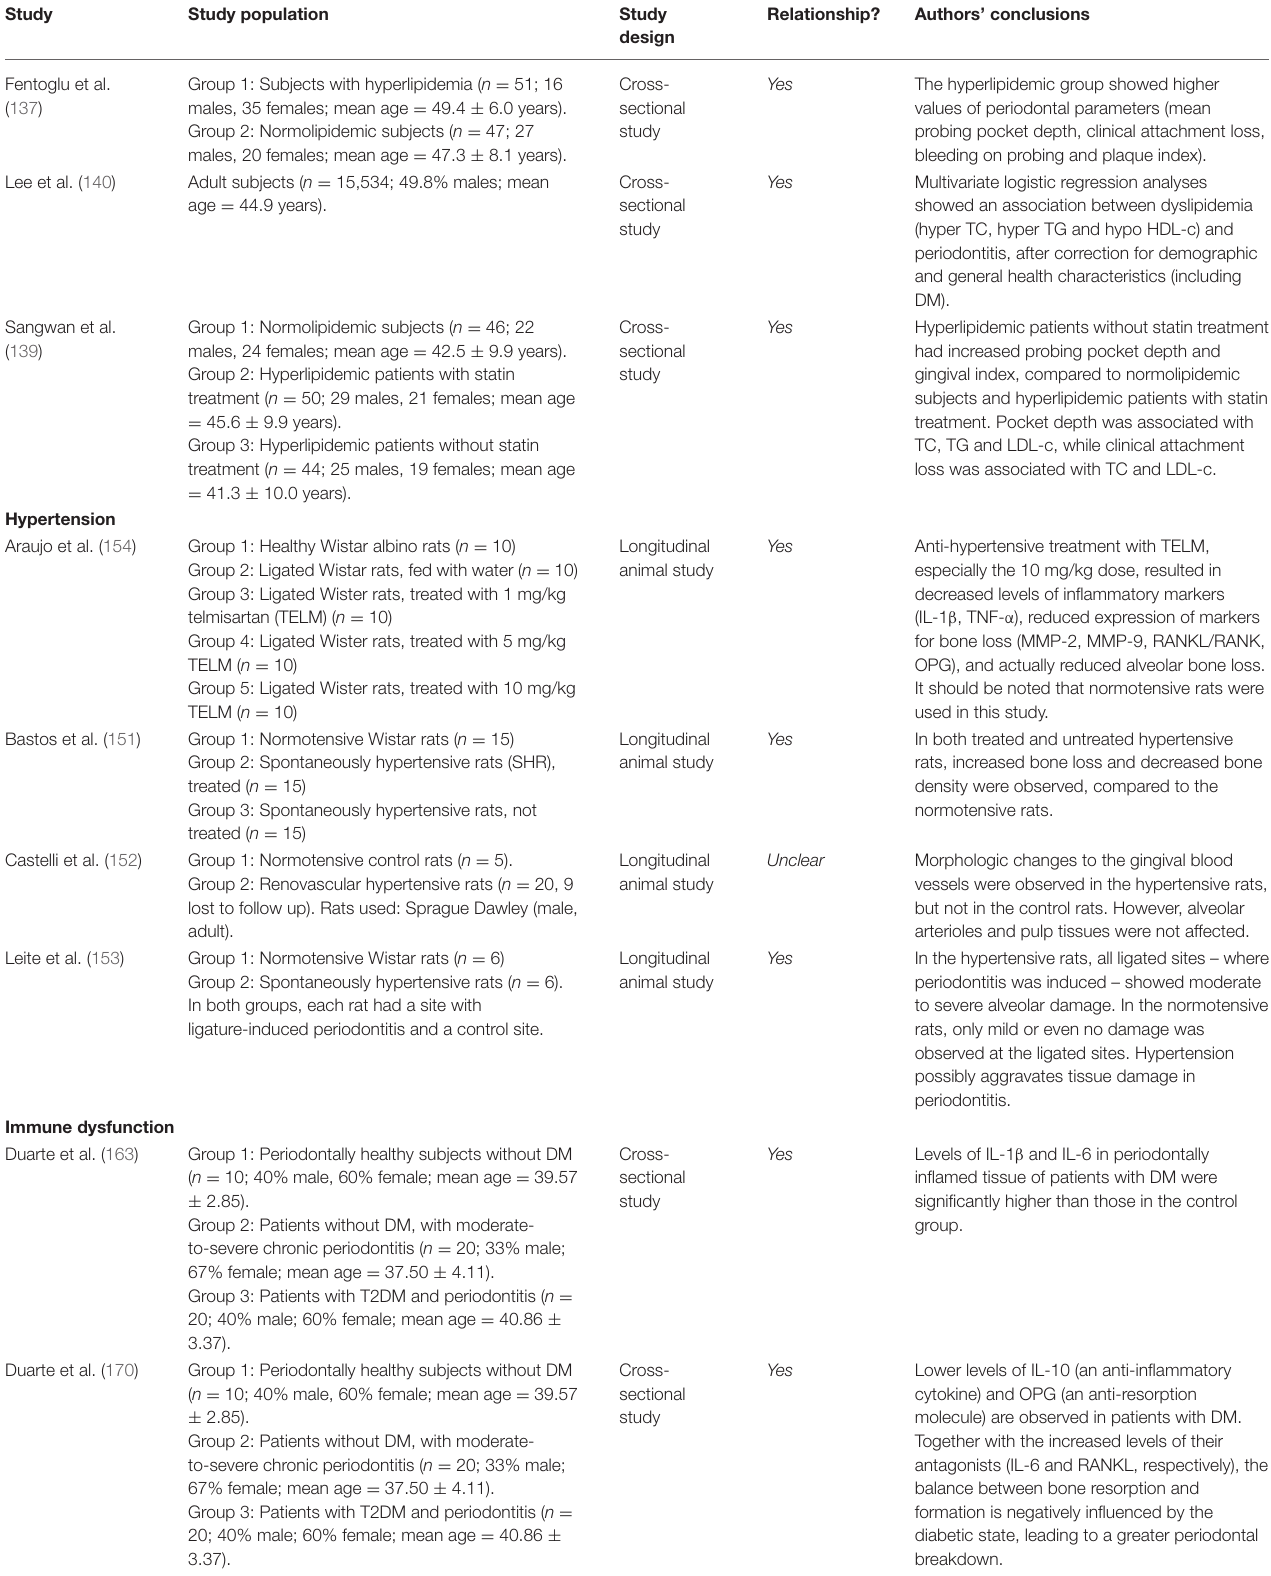
values of periodontal parameters (mean probing pocket depth, clinical attachment loss, bleeding on probing and plaque index). and general health characteristics (including DM).